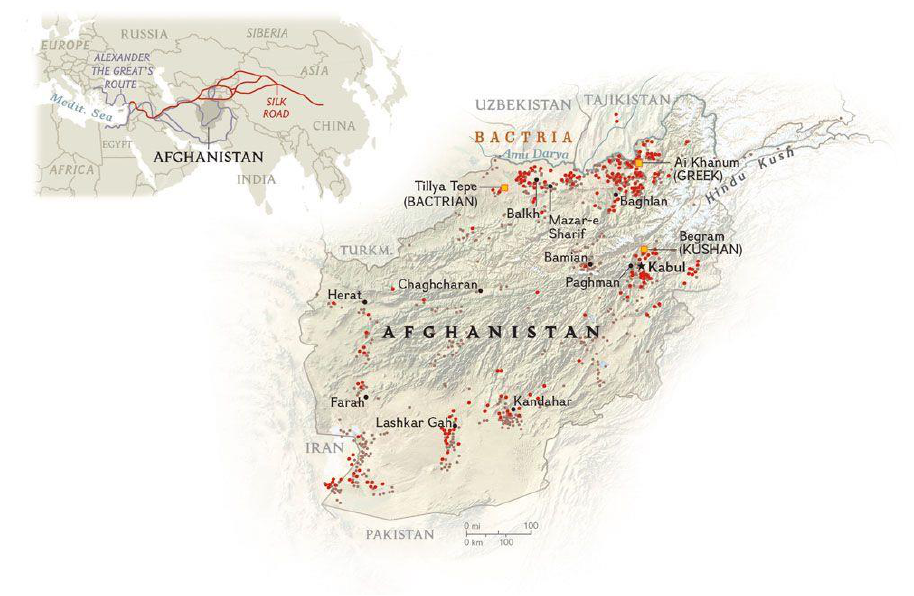
Figure 1 Location of Afghanistan within the extent of Silk Road (Berry,